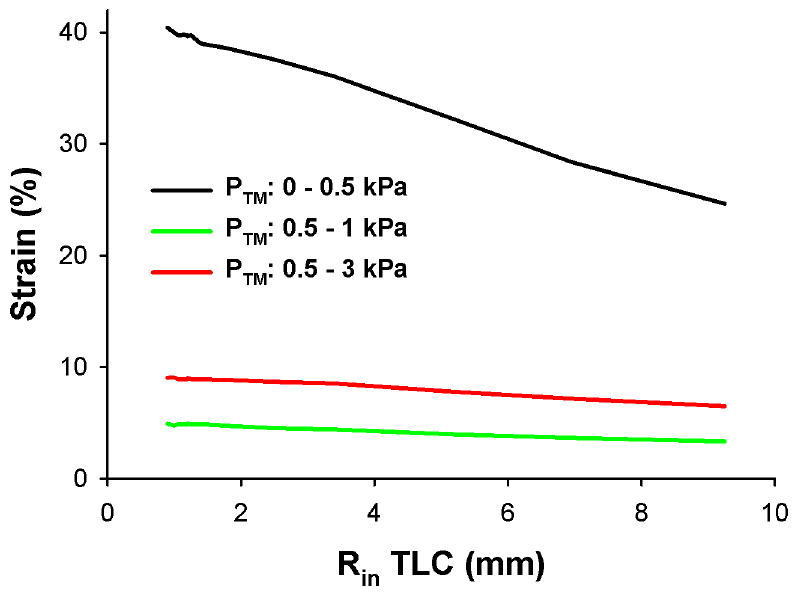
Figure 4. Distribution of circumferential strain throughout the airway tree. Strain was calculated as the relative % difference in airway radius at the inner wall, R in , for various changes in P TM (strain=[R in (P TM 2) 2 R in (P TM 1)]/R in (P TM 1) * 100%). Black line represents the strain corresponding to inflating an un-pressurized airway to P TM =0.5 kPa, approximately functional residual capacity. The green line and the red line represent the predicted strains during tidal breathing between 0.5 and 1 kPa P TM and deep inspiration between 0.5 and 3 kPa P TM , respectively.